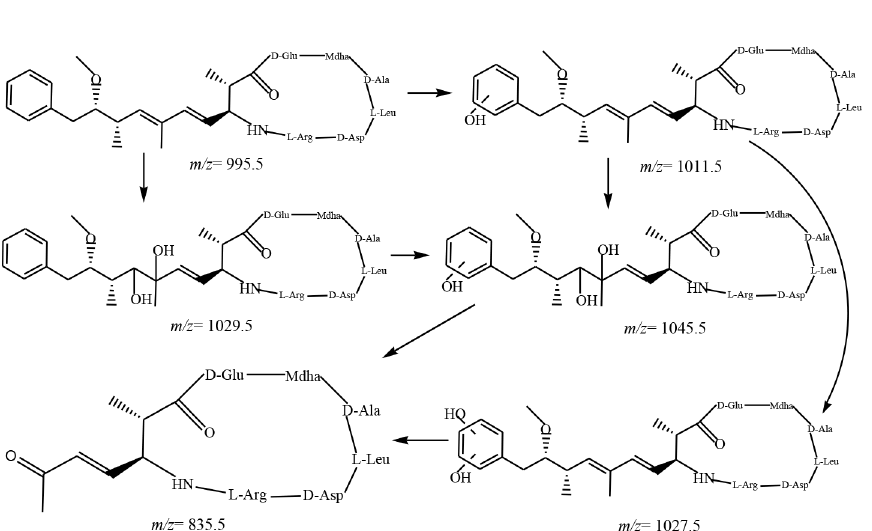
Fig 3. Byproducts and proposed reaction pathways for the combined UV/H2O2 degradation of the aromatic ring of Adda of MCLR.